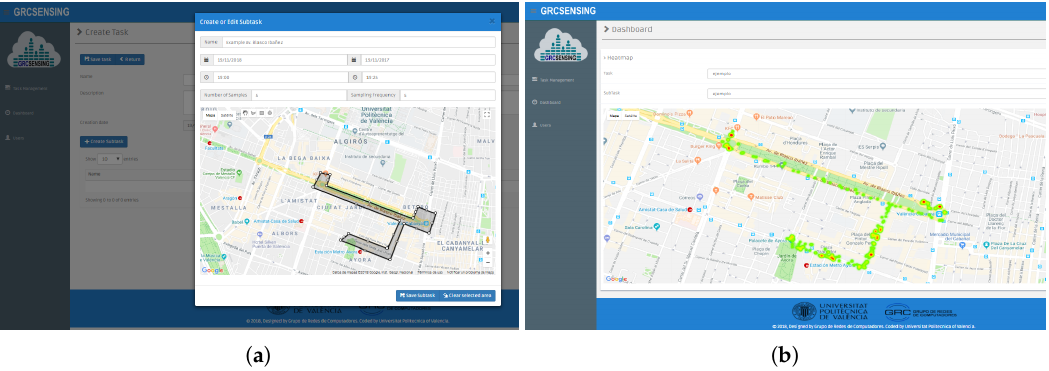
Figure 4. GRCSensing Web-based application. ( a ) Area definition using a polygon of n sides.; ( b ) Example of a heatmap detailing the noise